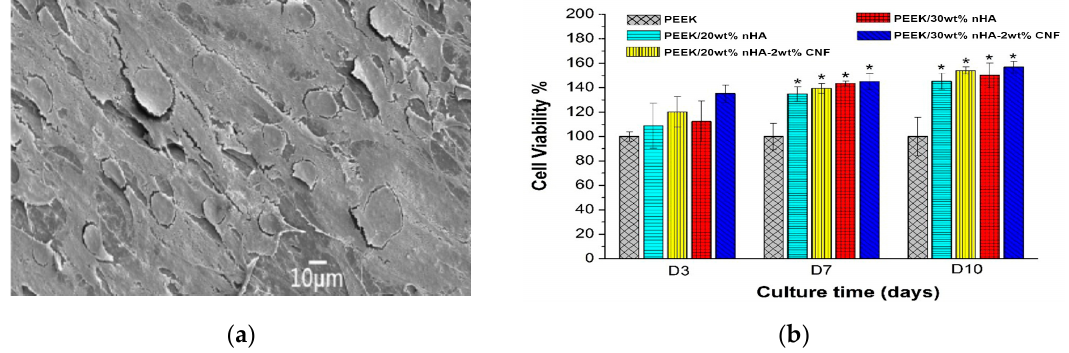
Figure 16. ( a ) Scanning electron micrograph showing the attachment of Saos-2 cells on PEEK/15 vol% nHA after culturing for 3 days. ( b ) Cell viability of Saos-2 cells on pure PEEK and its nanocomposites at different time points. * represents p < 0.05. Reproduced from [62] with permission of Royal Society of Chemistry.